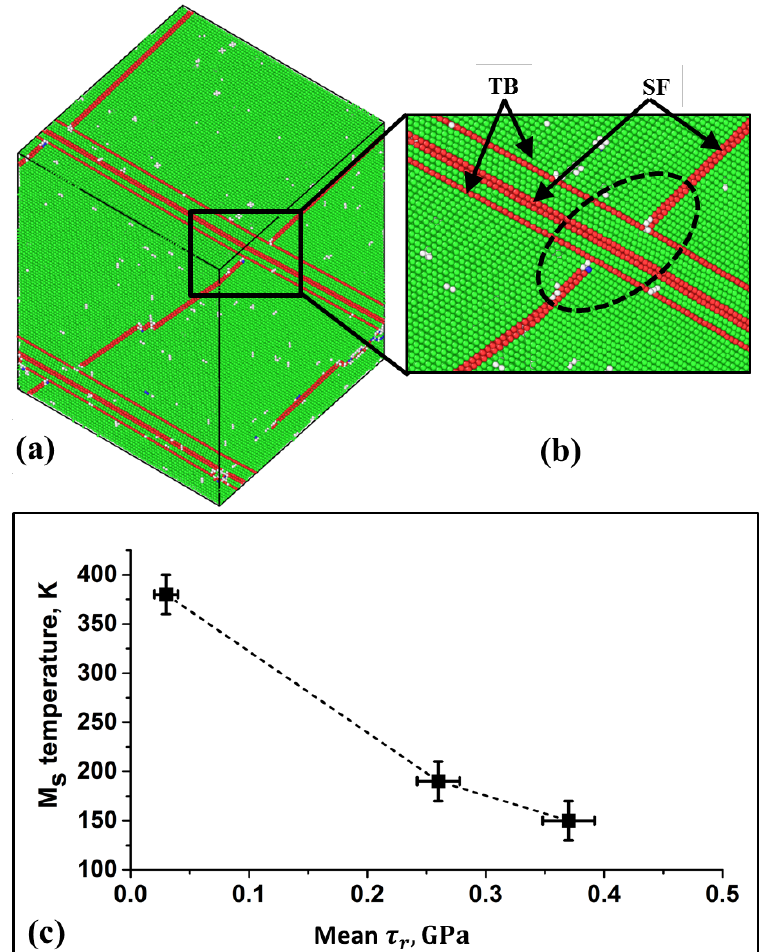
Figure 7. The simulation system with 70 × 70 × 70 unit cells along each direction at 400 K during cooling for Fe-0.25 at. %C concentration. ( a , b ) colour coded by a-CNA, inset shows the zoomed in view at the defect configurations. Dashed ellipse shows the intersecting SF and TB, and parallel SF and TB, ( c ) M s temperature vs τ r for bigger simulation system